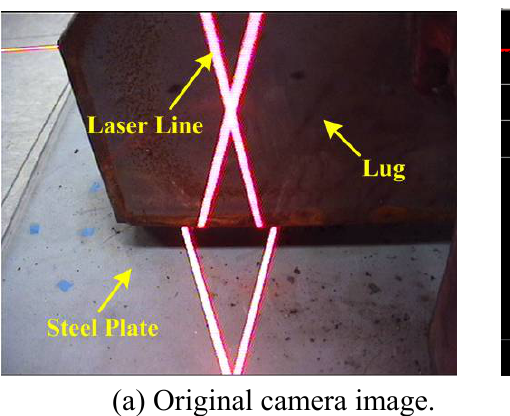
(a) Original camera image. (b) Detected welding line image.